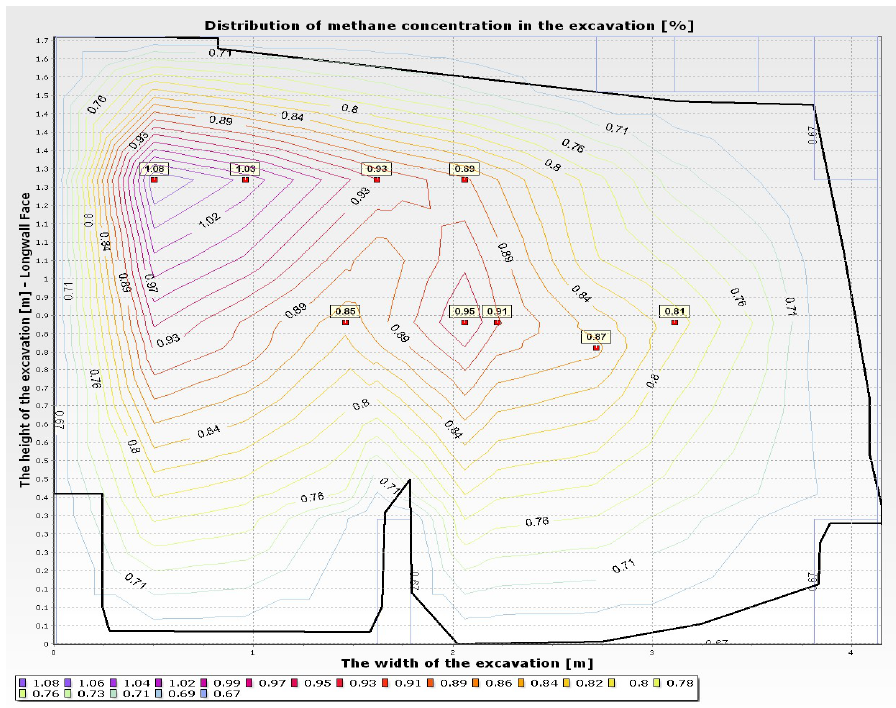
Figure 12. Methane concentration profile in the Cw-4 longwall cross-section at 8:00.